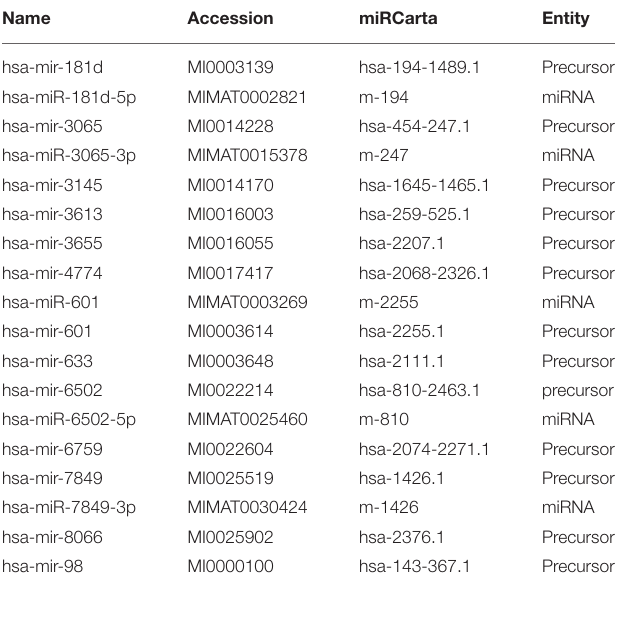
TABLE 1 | In silico analysis identifying miRs that contain the core AUUGUUG.